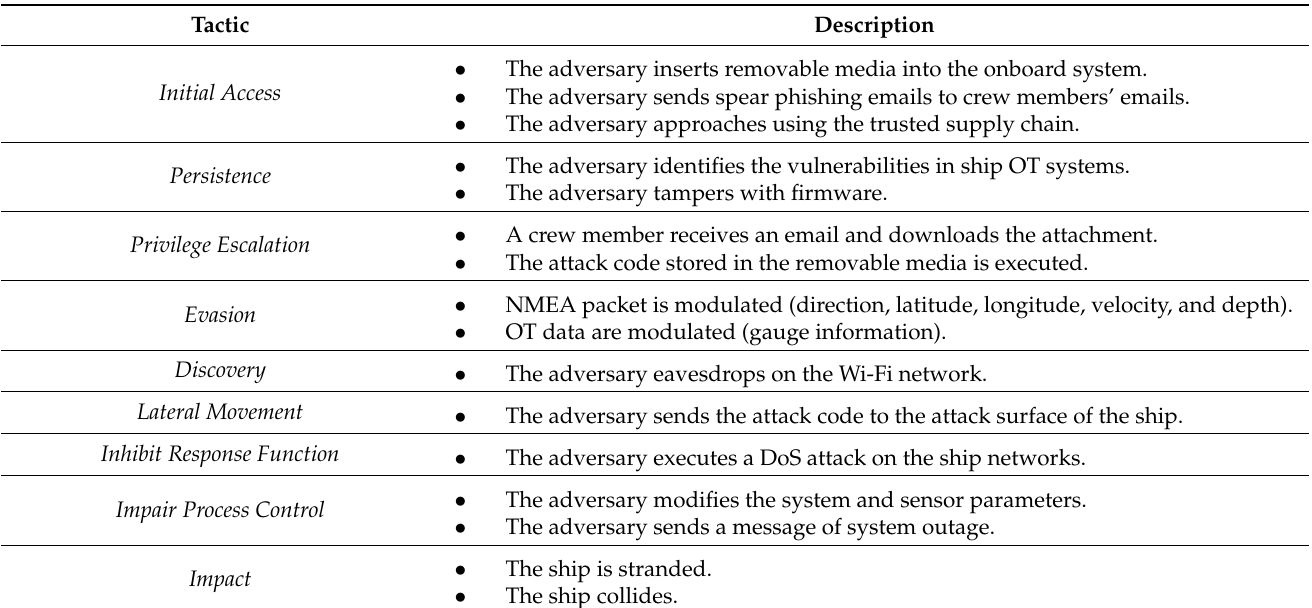
Table 9. Navigation system analysis